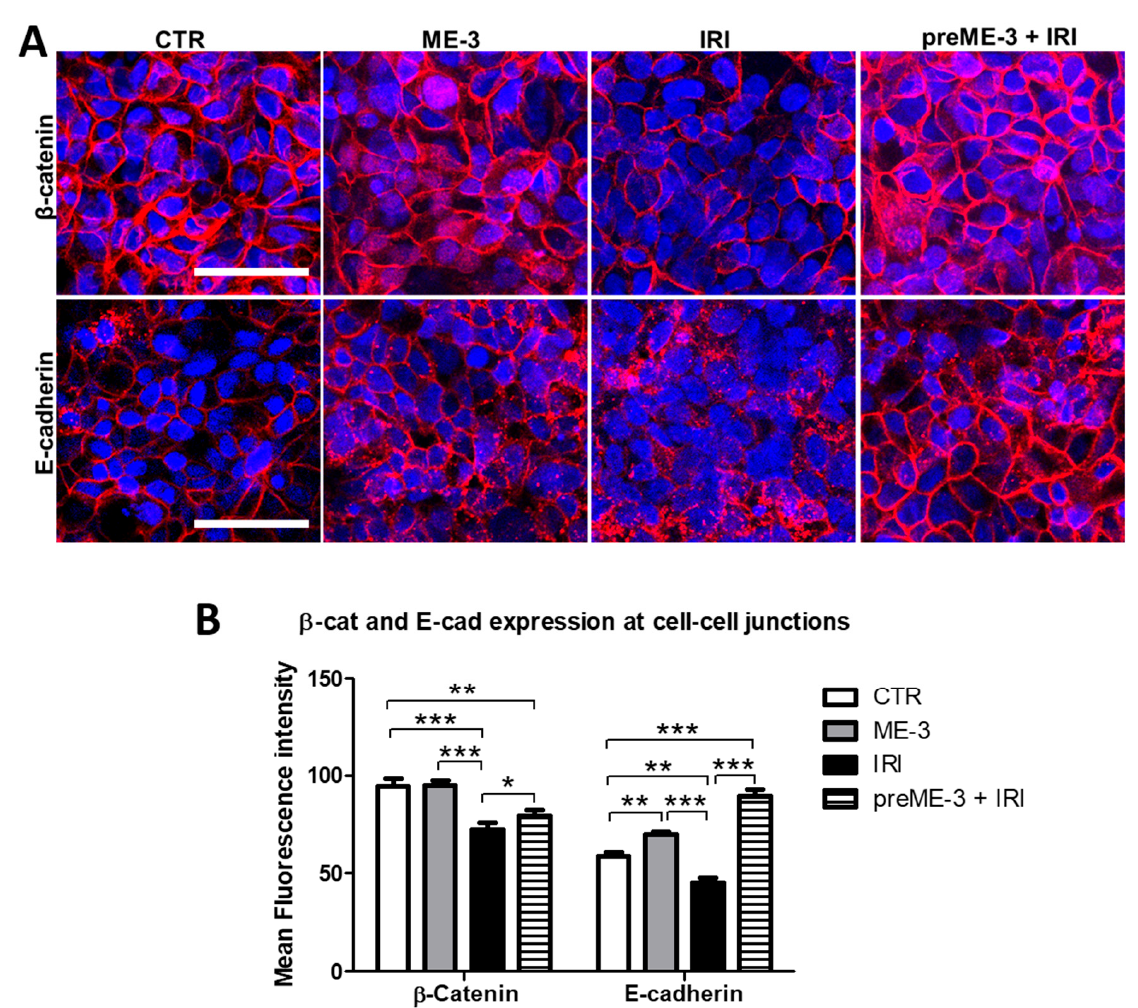
Figure 4. Effects of L. fermentum ME-3 ® on the expression and localization of proteins controlling the adherens junctions (AJs). ( A ) Confocal microscopy showing the immunofluorescence staining of β -catenin and E-cadherin at the AJs, in controls (untreated and ME-3 ® treated cells) and in IRI-treated cultures grown in the presence or absence of ME-3 ® pretreatment. Cell nuclei were counterstained with 0.2% Hoechst. Bars = 50 µ m. The bar graph in ( B ) represents the quantitative analysis of the distribution of the two AJ components, in controls and treated cells, measured as described in the Materials and Methods. Quantification of fluorescence intensity was carried out by analyzing a minimum of 100 cells/sample, and the results are the means ± SDs from three independent experiments ( n = 3). Significance (one-way ANOVA + Tukey’s multiple comparison test): * p < 0.05, ** p < 0.01, *** p <